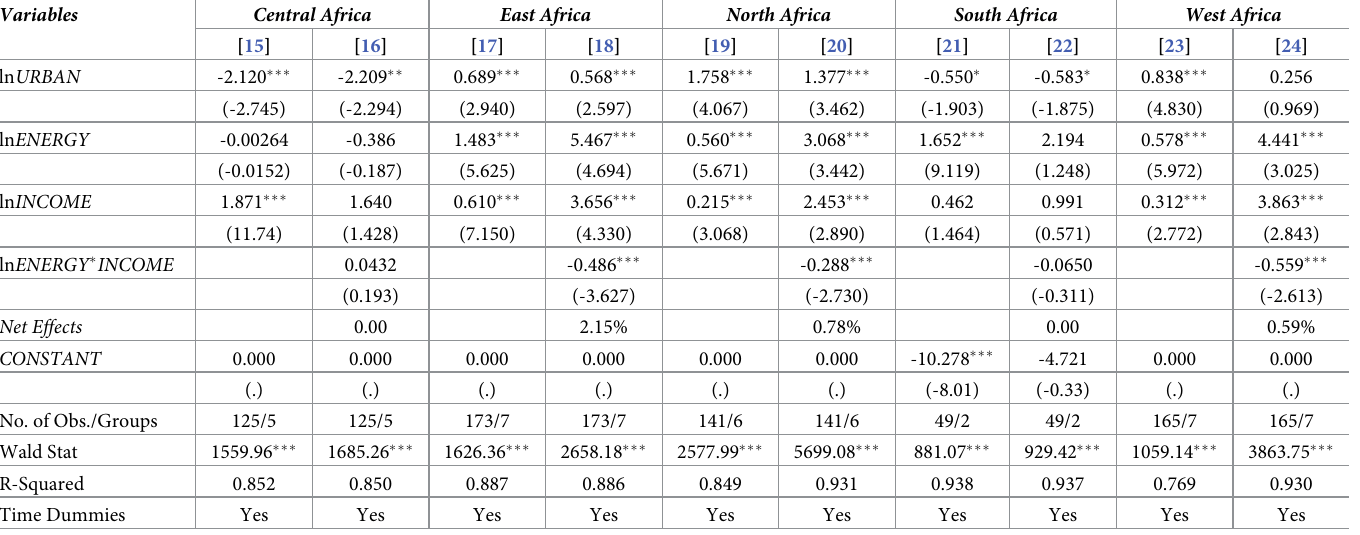
Table 5. PCSE Results for the Regions (Dep. Variable: